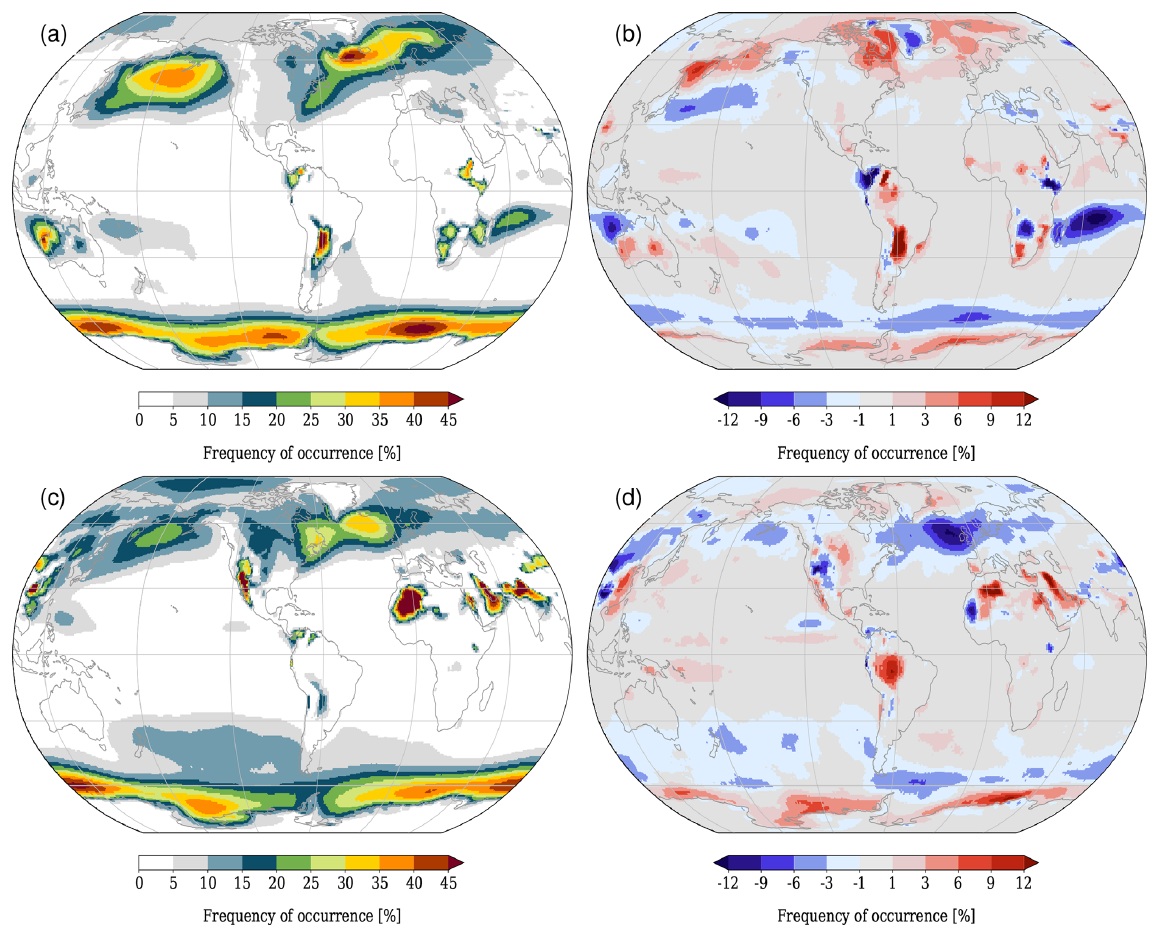
Figure 7. Absolute values of cyclone frequency for HIST in (a) DJF and (c) JJA and differences in cyclone frequencies between RCP8.5 and HIST in (b) DJF and (d)